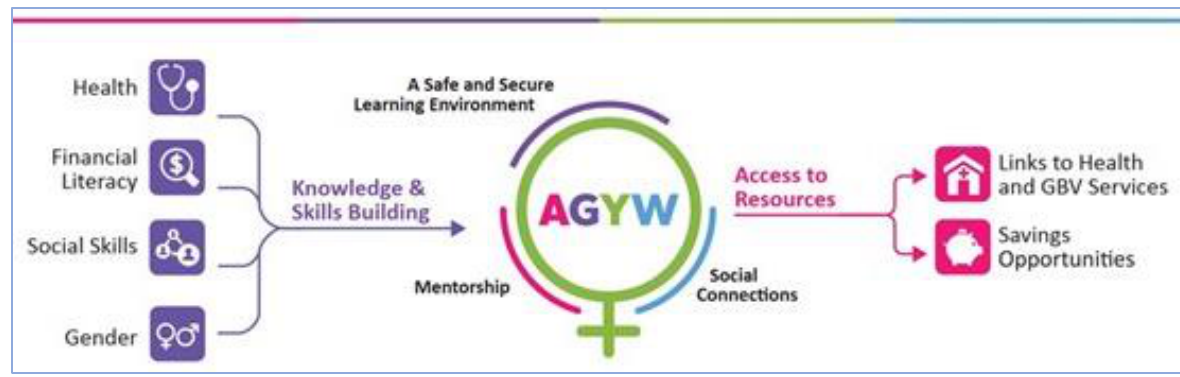
Figure 1. Program Alignment With Key Features of Positive Youth Development